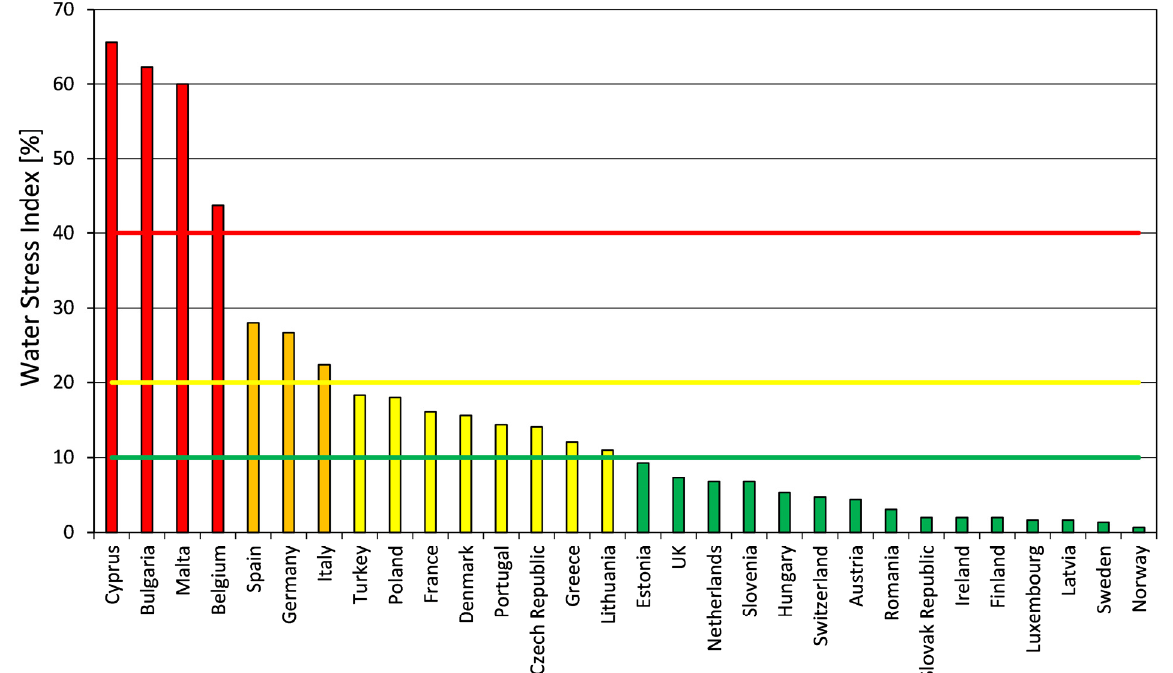
Figure 3. Water Stress index for European countries (Source: